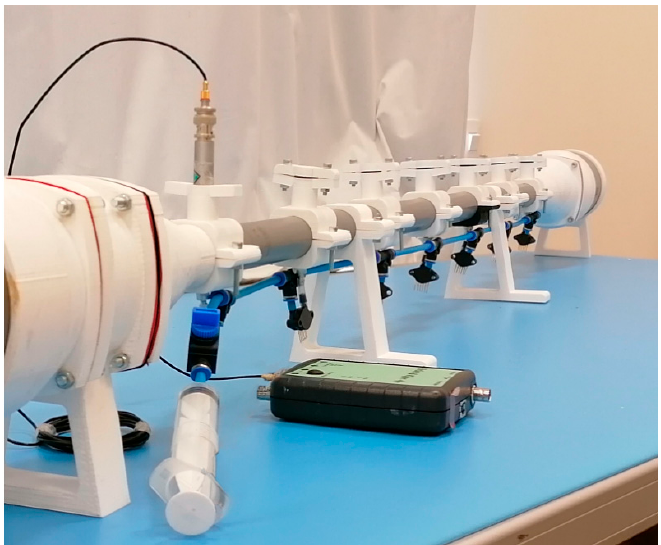
Figure 5. Pneumatic components used for the implementation of the auxiliary pressure line and its assembly on the acoustic bench.